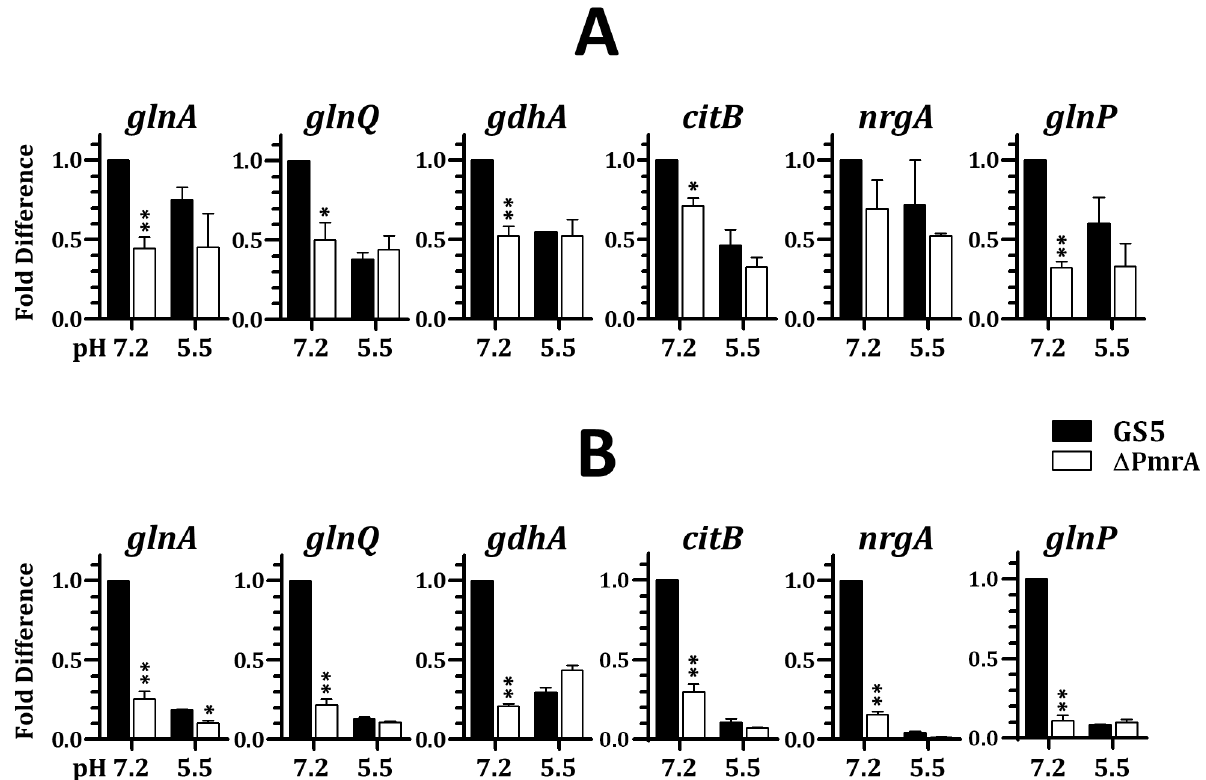
Fig 4. The impact of growth pH and carbohydrate concentrations on the regulatory activity of PmrA. Wild-type GS5 and strain Δ PmrA were grown in chemostat in TY containing 20 mM (A) or 100 mM glucose (B) at pH 7.2 or pH 5.5. The relative quantity of mRNA of the GlnR regulon gene was measured by qPCR. The Δ Cq of GS5 grown at pH 7.2 was used as the reference. Numbers are the means and standard deviations of three independent experiments. The significant difference between wild-type GS5 and strain Δ PmrA under each growth condition was determined by Student ’ s t test. ** , P < 0.001; * , P <